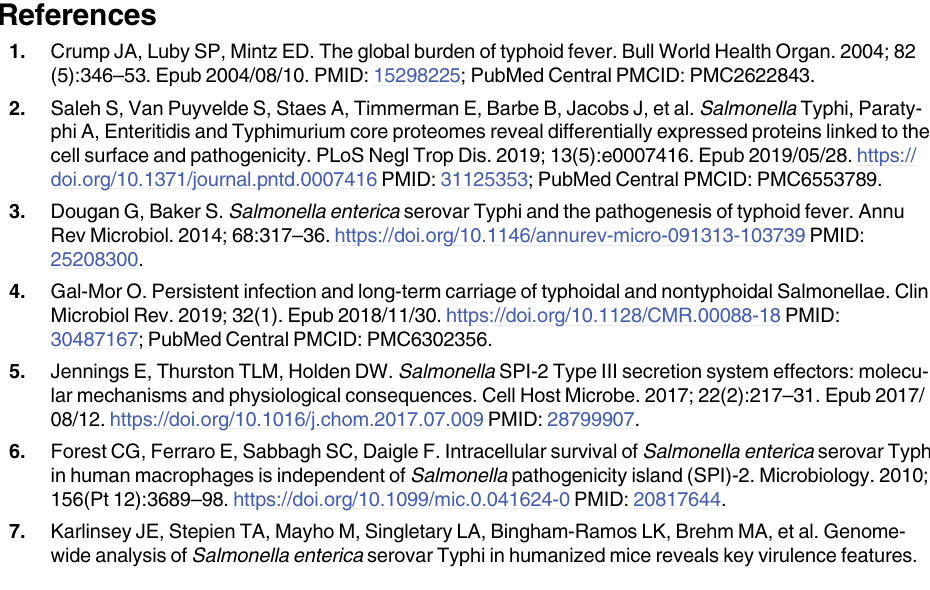
S2 Table. Antibodies used in this